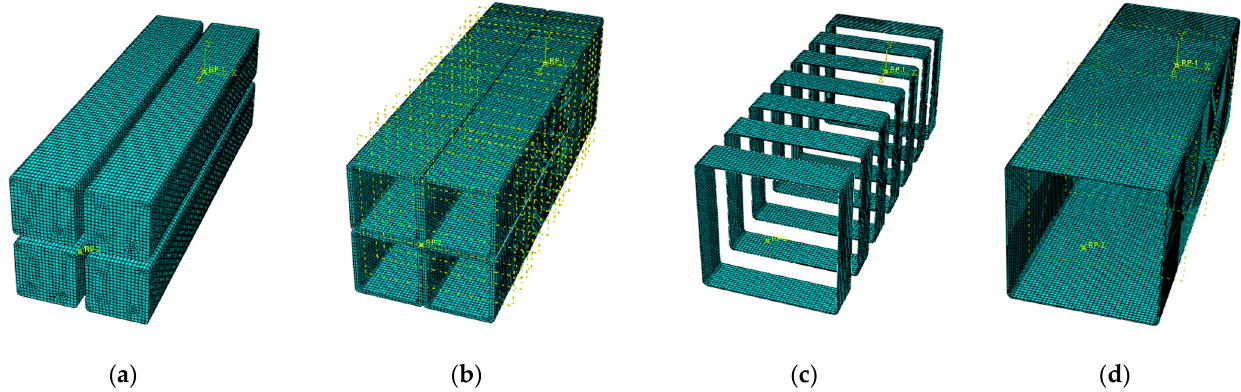
Figure 8. Meshing of finite element model: ( a ) Internal Concrete; ( b ) GFRP tubes; ( c ) GFRP strips interval wrapped; ( d ) GFRP entirely wrapped.